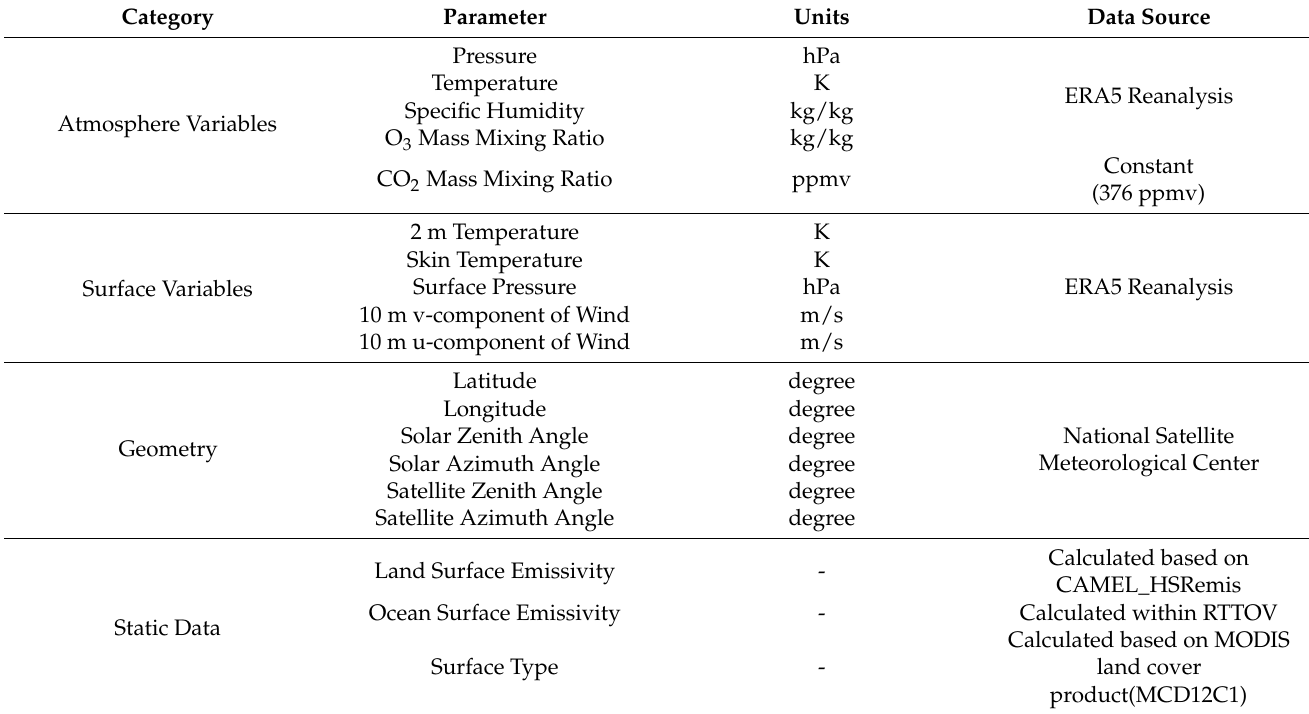
Table 2. Input variables and parameters for clear-sky simulations with RTTOV